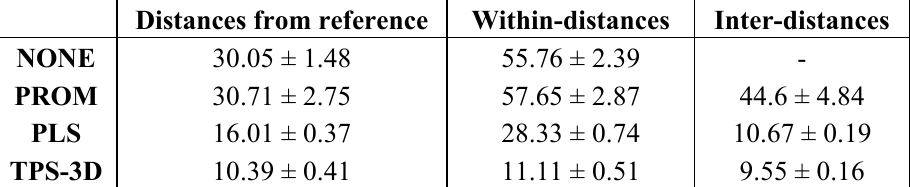
Table 1. Results of the Calibration Experiments: Mean ± Standard Error (SE) of the calculated distances (see Material and Methods section for further details).